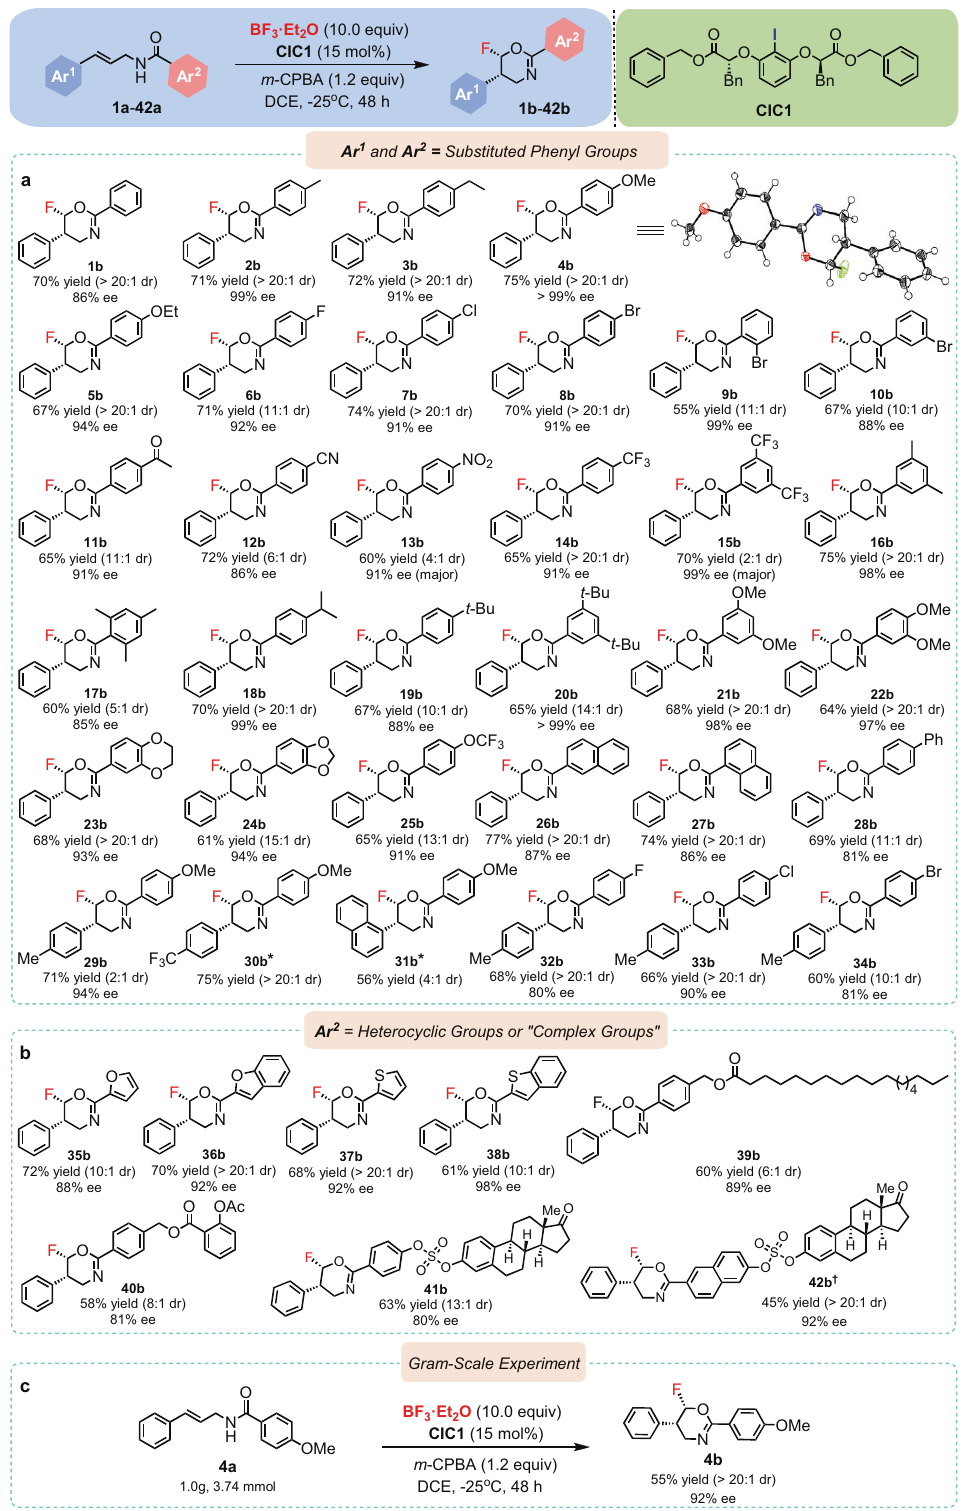
Fig. 3 Substrate scope of the nucleophilic asymmetric fl uorinations. Reactions were conducted on a 0.2 mmol scale with 10.0 equivalents of BF 3 ·Et 2 O in DCE (8.0 mL) at − 25 °C for 48 h. The absolute con fi guration of 4b was assigned by X-ray crystallography (structure shown), and the con fi guration of all other products was assigned by analogy. a Substrate scope of N -cinnamylbenzamides bearing various substituents on Ar 1 and Ar 2 ring. b Substrate scope of N -cinnamylbenzamides with “ complex substituents ” on Ar 2 ring and Ar 2 = heterocyclic groups. c Gram-scale reaction with 4a , CIC1 , m -CPBA and BF 3 ·Et 2 O. Isolated yields are reported. *The ee values of 30b and 31b could not be detected by HPLC. † CIC2 was employed as the catalyst for 42b . The ee values were determined by chiral HPLC analysis and the dr values were determined by 19 F NMR. t -Bu, tert -butyl; Ph, phenyl; Me, methyl; Ac,